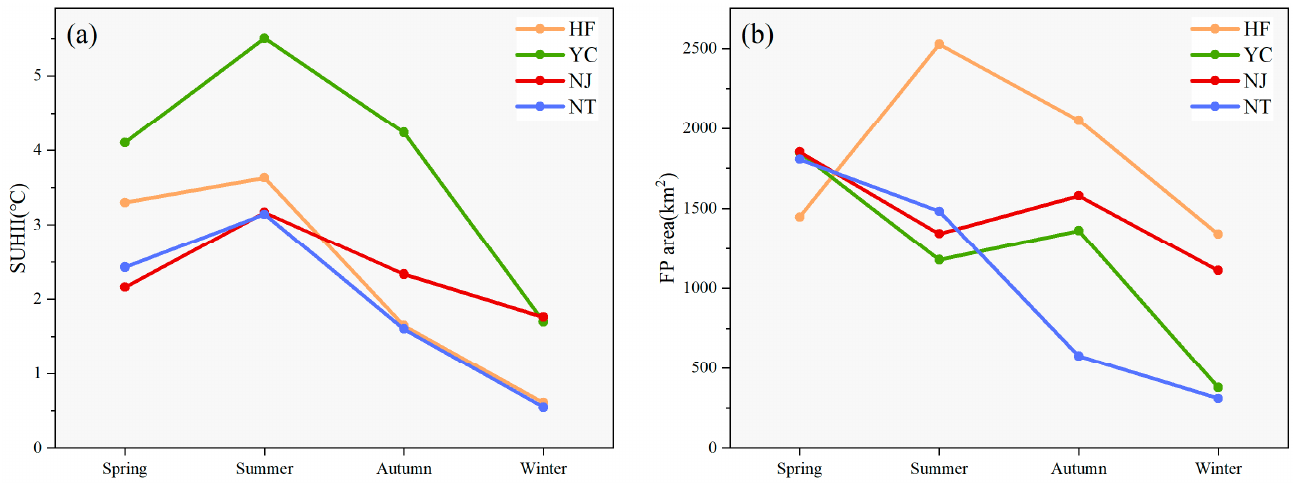
Figure 10. Surface urban heat island intensity and footprint area in four cities. ( a ) Surface urban heat island intensity; ( b ) footprint area.